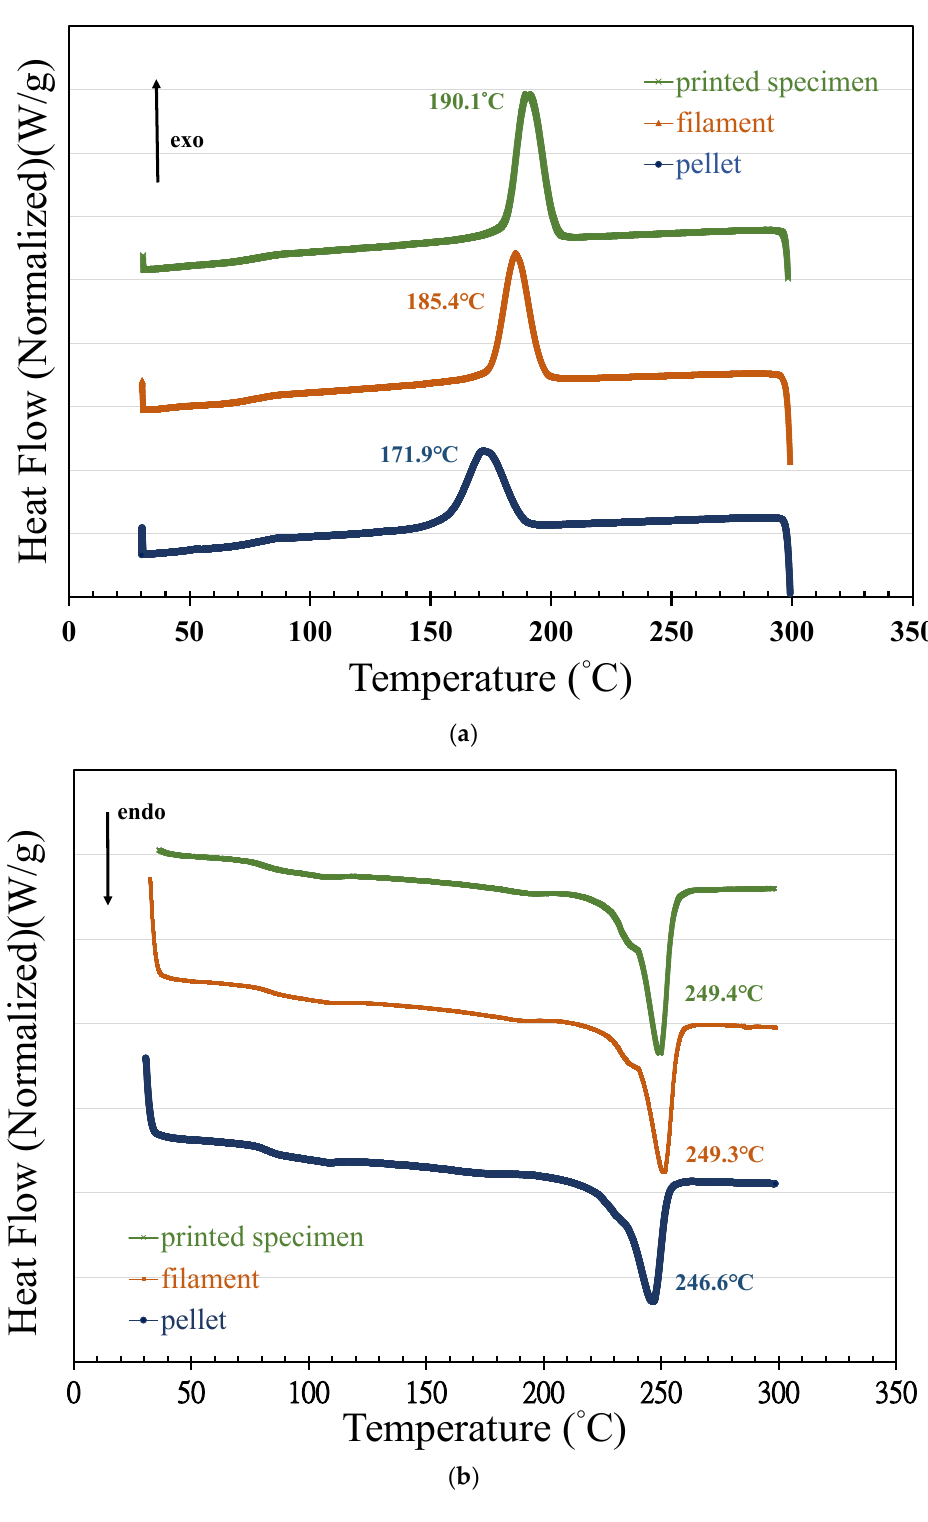
Figure 5. DSC scans: ( a ) cooling runs from the melted pellets, filament, and printed specimen; ( b ) second heating runs based on DSC scans of the melted pellets, filament, and printed specimen. Figure 5b shows the curves of the second heating scan used to study the influence of ing temperatures of the virgin PET pellets, extruded filament, and printed specimen grad- ually decreased with respect to the history of the mechanical and thermal process. The